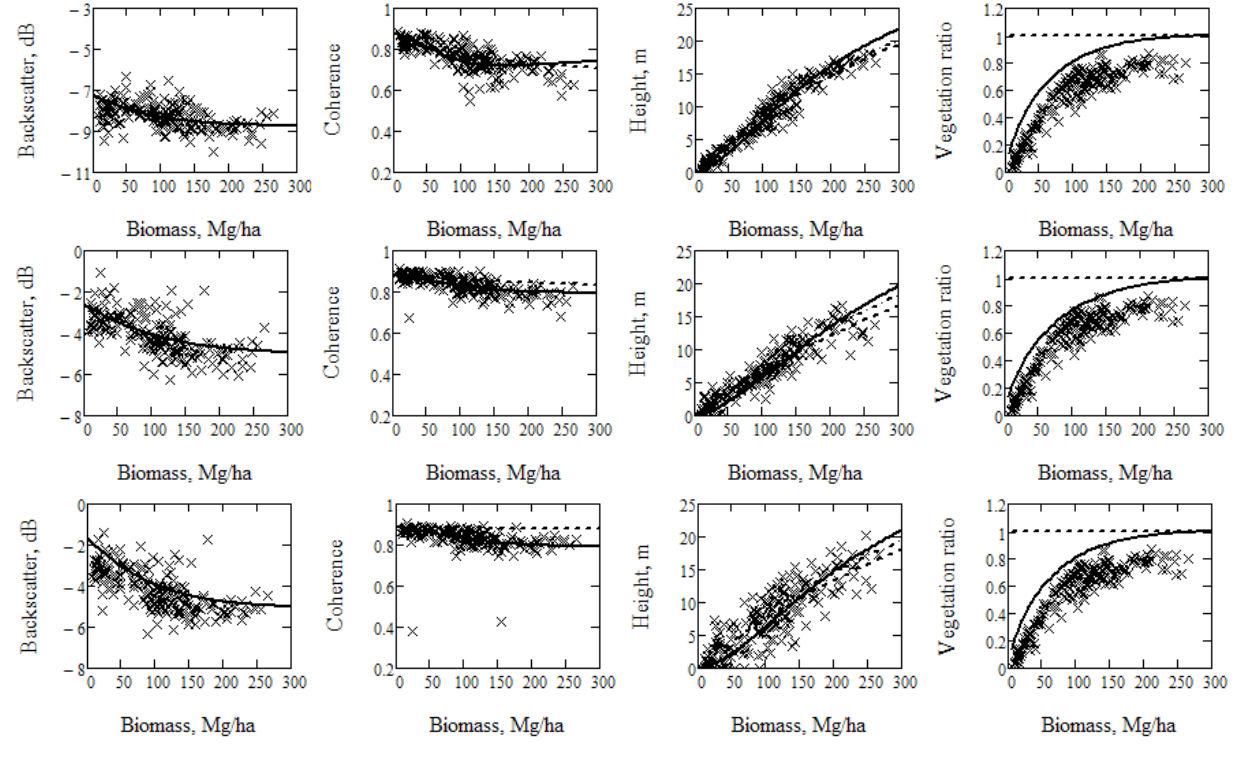
bottom 2012-02-01 (HOA = 80 m), 2011-11-23 (HOA = − 185 m), and 2012-08-13 (HOA = 358 m). IWCM results for backscatter, coherence, TDM height and vegetation ratio (area-fill): solid line, RVoG results for coherence and TDM height: dashed line, and PD results for TDM height: dash-dotted